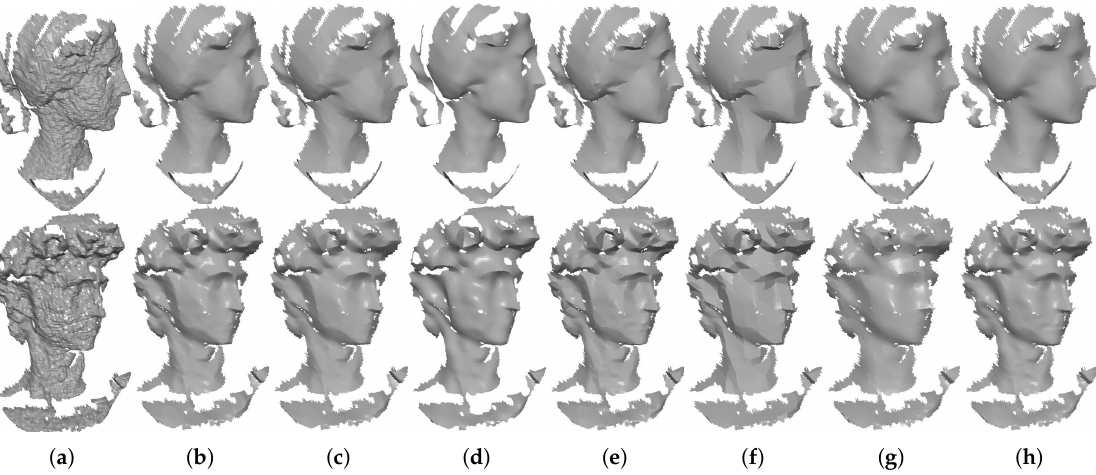
Figure 9. Denoising results of Big-Girl-01 and David captured by Kinect v2. From left to right: ( a ) noisy meshes, denoising results produced by ( b ) our method TS; ( c ) HO [1]; ( d ) RHM [14]; ( e ) TV [21]; ( f ) (cid:96) 0 [20]; ( g ) localBF [12]; and ( h ) globalBF [12],